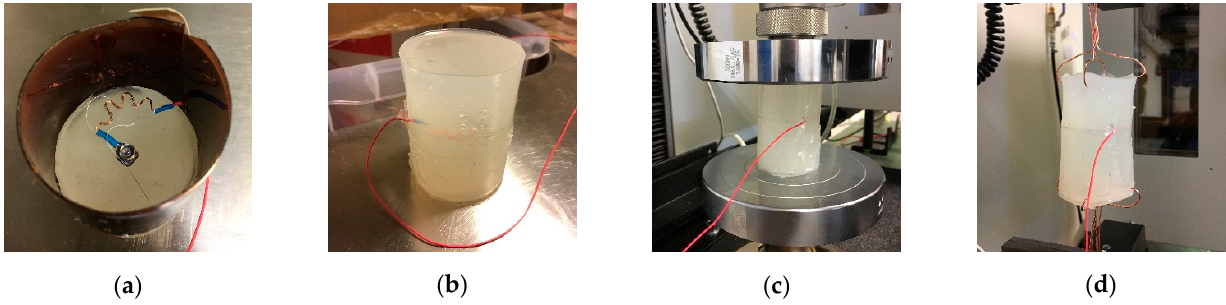
Figure 5. Preparation and testing of the uniaxial pressure sensor: ( a ) Pressure sensor positioned over the first half of the rubber specimen. ( b ) Cylindrical specimen ready for the test. ( c ) Compression test. ( d ) Tension test.